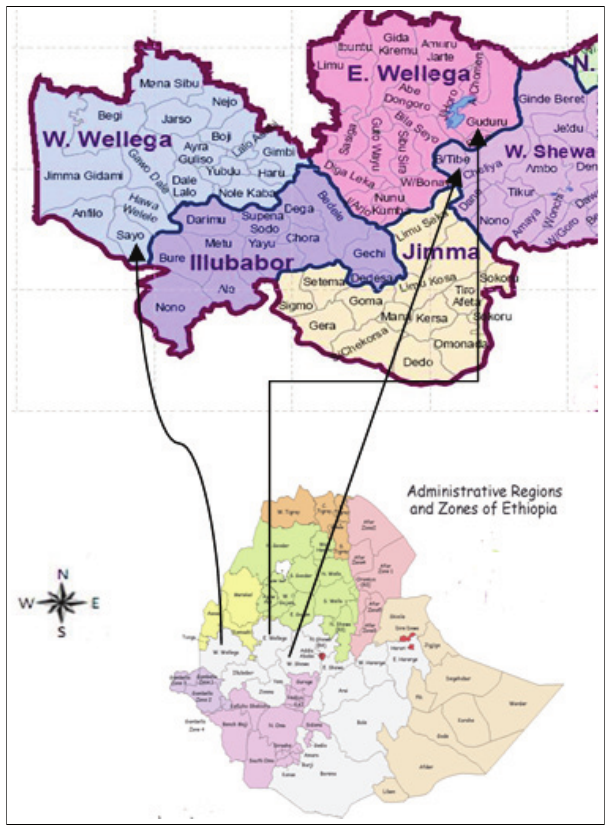
Oromia.pd FIGURE 1: Map showing the location of the study